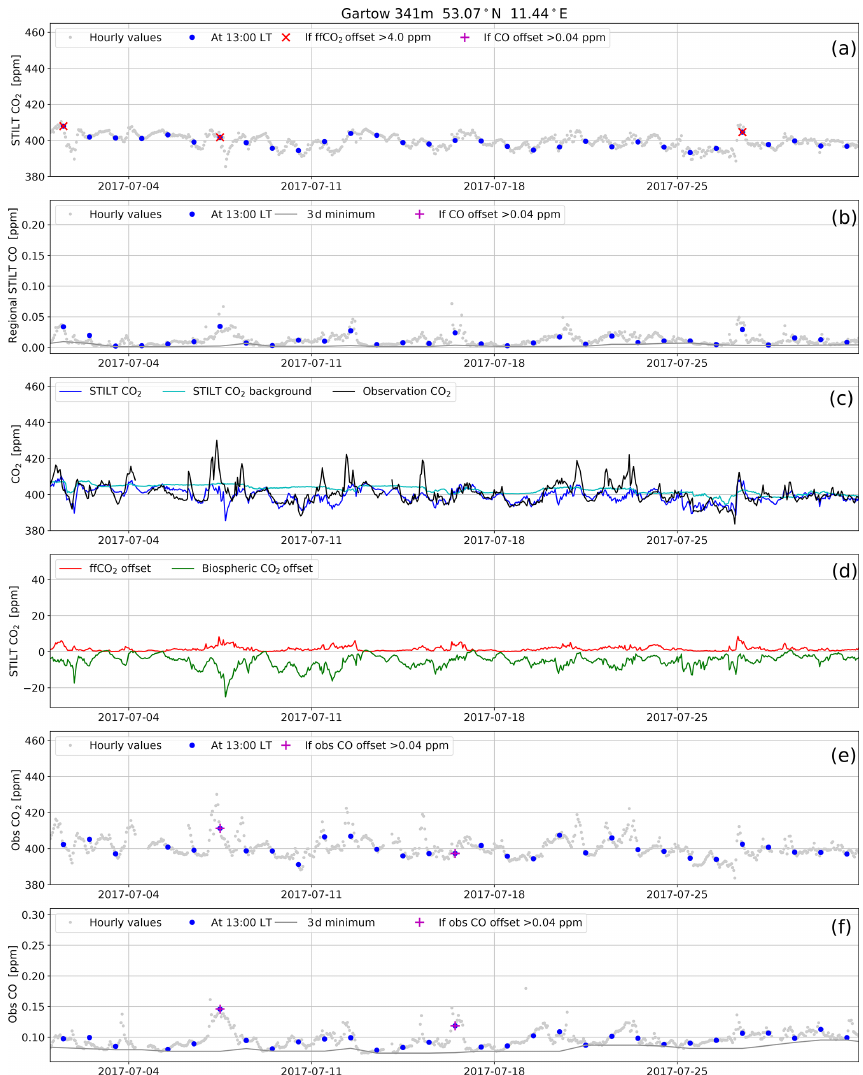
Figure 7. Variability of STILT-simulated (a–d) and measured (c, e, f) CO 2 and CO concentrations at Gartow at the 344 or 341m level in July 2017. Afternoon values are highlighted with coloured symbols (blue dots) and situations with elevated ffCO 2 , based on modelled or measured CO (CO offset > 0 . 04ppm), are marked with a magenta cross in the CO and also in the CO 2 records (clearer in Fig. 8 for October 2017 when such situations occur more often). CO offsets in STILT model simulations (b) and observations (f) were estimated relative to the minimum CO concentration of the last 3d (grey